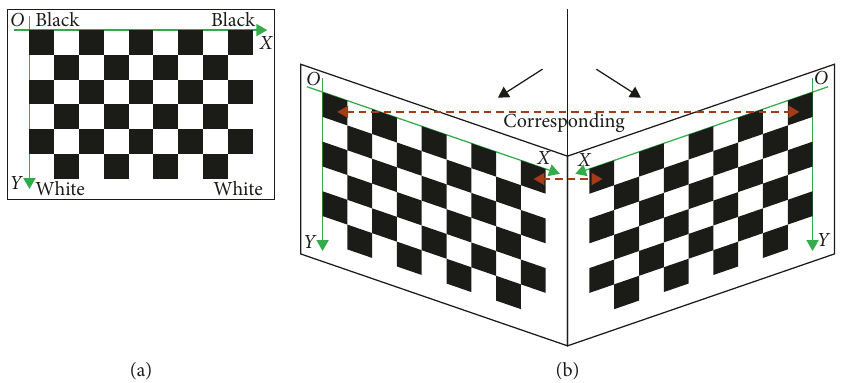
Figure 10: The coordinate system definition of the calibration